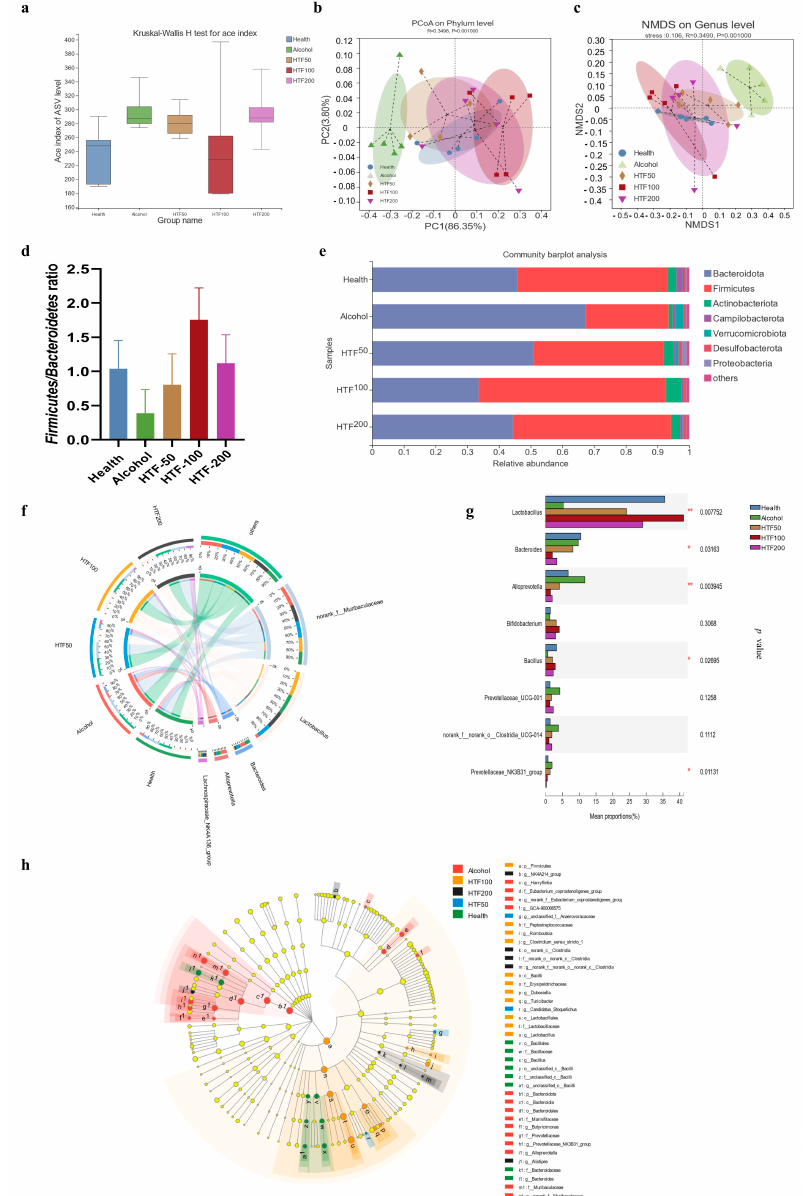
Figure 4. HTF reshaped the gut microbiota in alcohol-induced mice. ( a ) α -Diversity representing the Ace index at the ASV level. ( b ) PCoA plot of the gut microbiota based on weighted UniFrac matrixes. ( c ) Typing analysis of the phylum level in different treatment groups. ( d ) The Firmi- cutes/Bacteroidetes ratio of all groups. ( e ) Analysis of gut microbiota composition at the phylum level. ( f ) Relative abundance of the fecal microbiota with relative abundance greater than 1% at the phylum level. ( g ) Analysis of gut microbiota composition at the genus level. ( h ) Indicator bacteria of intestinal microbiota with LDA scores of 2 or greater in mice with different treatments. Data are mean ± SEM ( n = 5 per group). * p < 0.05, ** p < 0.01 vs. the alcohol